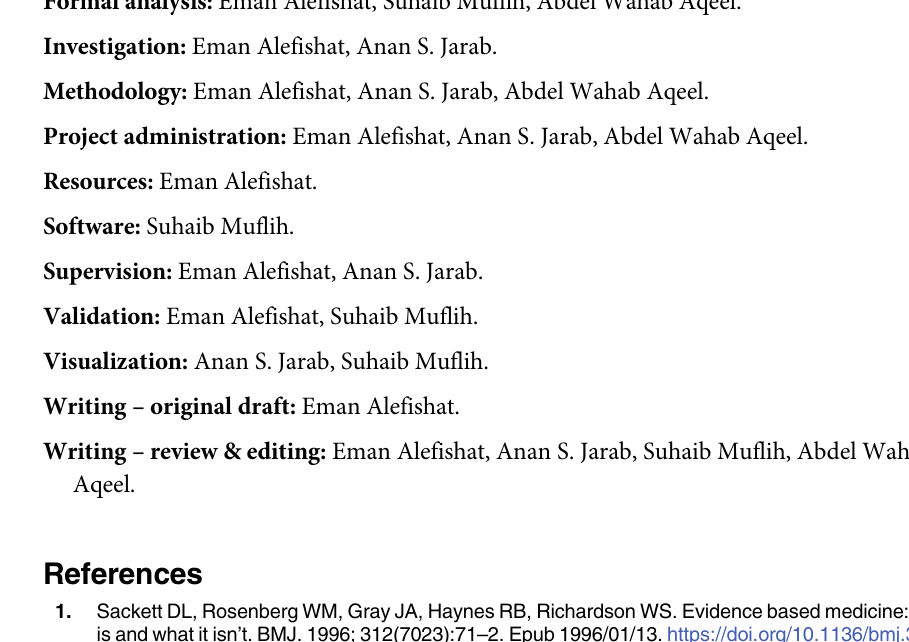
S1 Table. Intercorrelations for pharmacists’ utilization of best current scientific evidence and predictor variables (N = 169). S2 Table. Results of exploratory factor